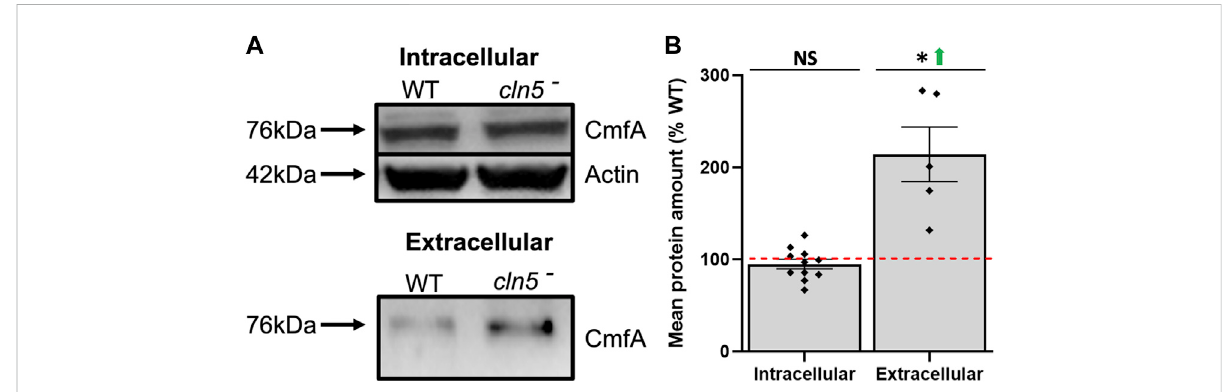
FIGURE 4 Loss of cln5 affects the extracellular amount of CmfA during starvation. (A) WT and cln5 -de fi cient cells starved for 4 h were lysed and standard SDS-PAGE/western blotting was performed on equalproteinamounts from whole cell (WC) lysates (20-40 µg) and clari fi edconditioned buffer(CB) (0.15 – 0.375 µg). Membranes were probed with anti-CmfA and anti- β -actin (loading control). (B) Intracellular and extracellular amounts of CmfA were quanti fi ed with Fiji/ImageJ and intracellular amounts of CmfA were standardized against the levels of β -actin. Data presented as mean